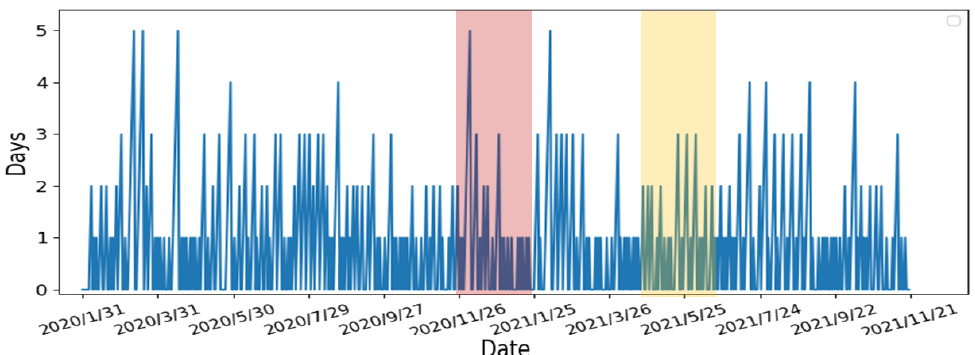
Figure 12. The number of growing days in the UK’s Daily Confirmed Cases between 31 January 2020 and 21 November 2021.